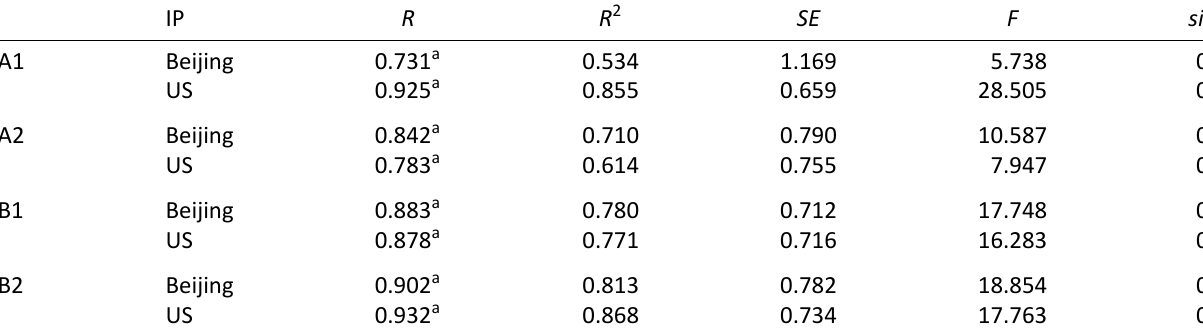
Table 7. Multiple linear regression analysis results related to believability in different